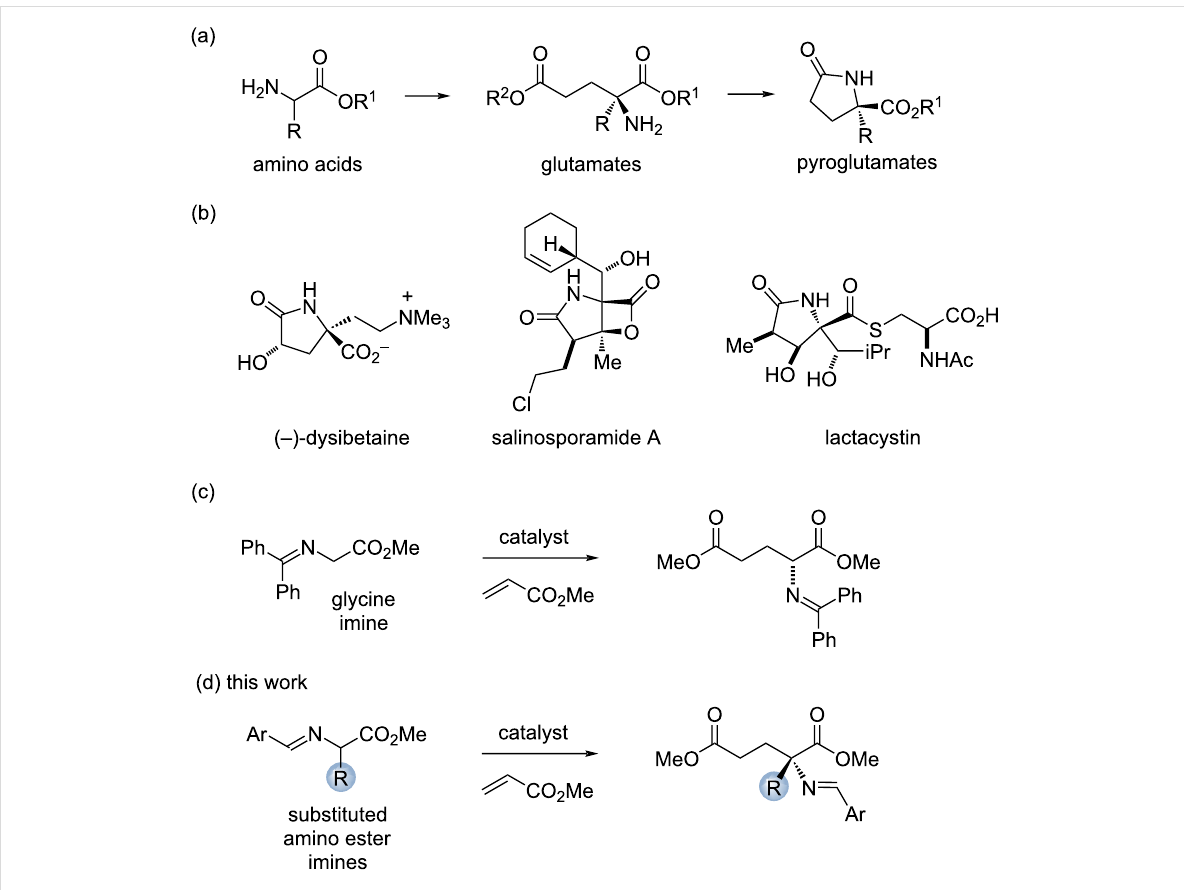
Figure 1: Strategy for the synthesis of glutamate and pyroglutamate derivatives and several natural products with pyroglutamate substructures.